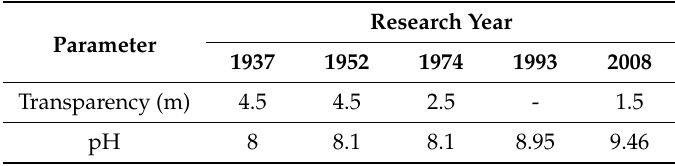
Table 1. Changes in water transparency and pH in G ó reckie Lake from 1937–2008